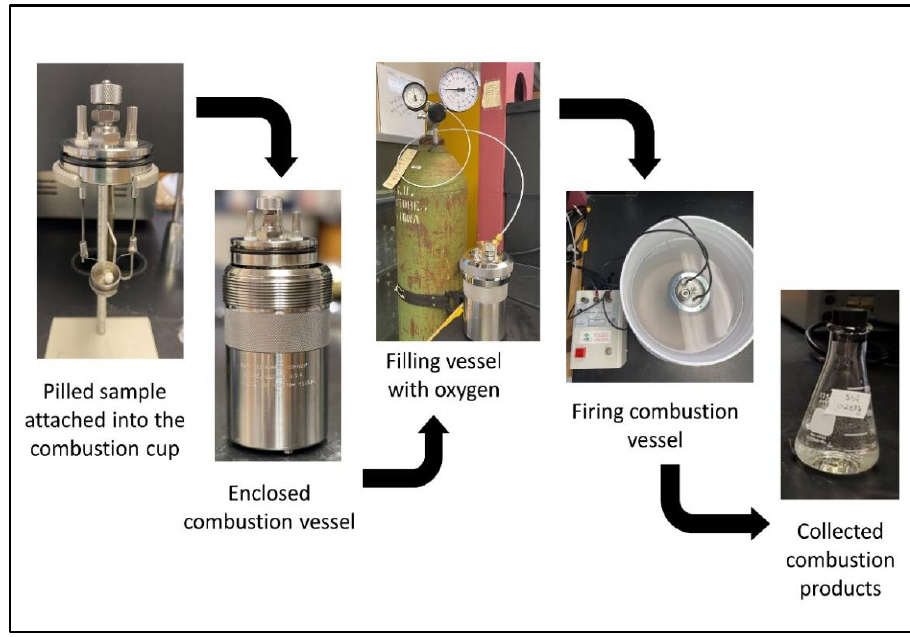
Figure 4. Combustion process procedure.